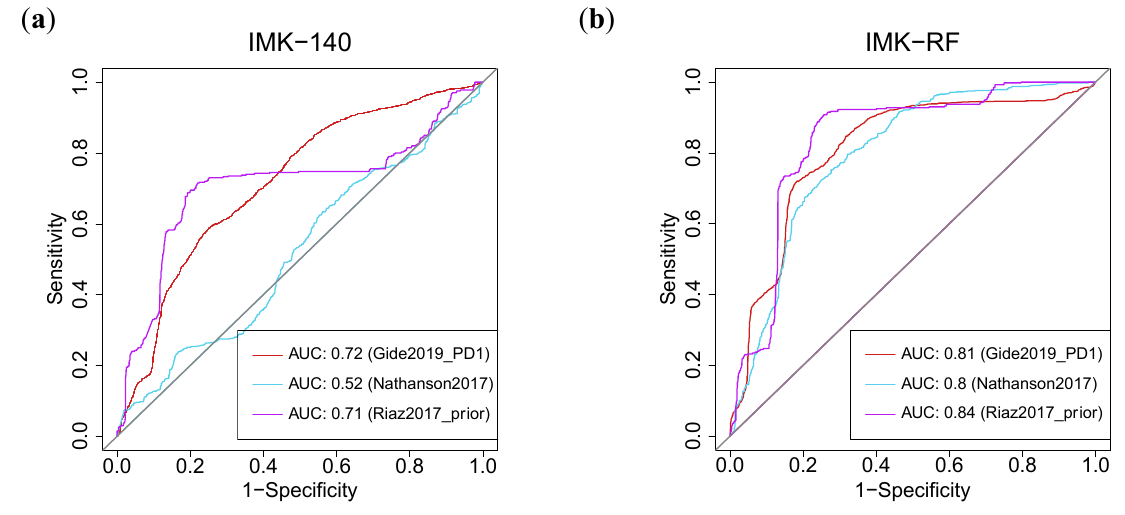
Figure 8. Machine-Learning-based predictive power of the transcriptomic signature. ROC curve for the ( a ) 140-genes model by cross-validation (CV) and ( b ) Random Forest (RF) model in three different external cohorts.